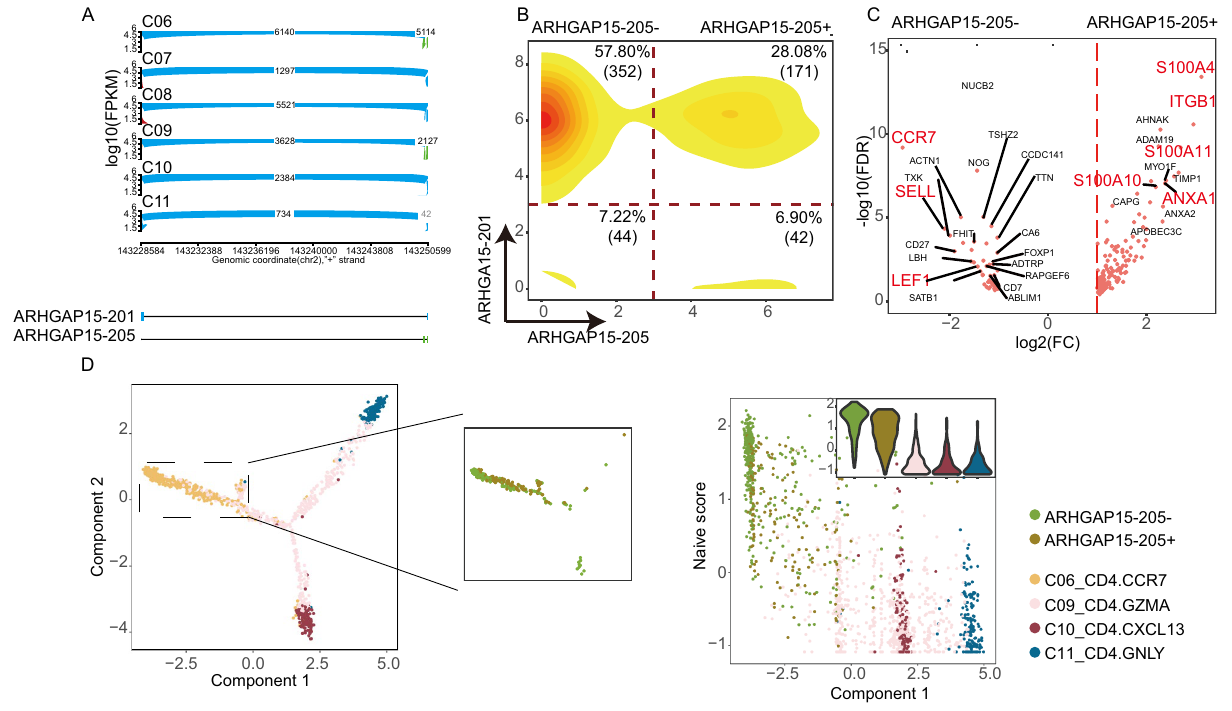
Figure 4. A novel functional subpopulation in activation state identified by ARHGAP15-205. ( A ) Sashimi plots illustrating the read distribution of ARHGAP15 in CD4 + T cells from patient P0508. ARHGAP15-205 is highly expressed in naïve T cells (C06_CD4.CCR7). ( B ) The bimodal distribution of ARHGAP15-205 shows the intrinsic heterogeneity in naïve T cells (C06_CD4.CCR7). Cell density is color-coded, with red denoting high density and yellow denoting low density. ( C ) Volcano plot showing DEGs between the ARHGAP15-205 + and ARHGAP15-205 − populations. Each red dot denotes an individual gene with an adjusted p- value < 0.01 (two-sided moderated t -test with limma) and fold change > |2|. ( D ) Left: CD4 + T helper cells were ordered along pseudotime in a two-dimensional state-space defined by Monocle2. Cell orders are inferred from the expression of DEGs across CD4 + T cell populations. Each point with different colors corresponds to individual cells in different clusters. The middle plot shows the order of the ARHGAP15-205 + and ARHGAP15-205 − populations. Right: The exhaustion score calculated by the mean expression of gene sets related to naïveness status correlated with Monocle components. Violin plots in the top corners show the distribution of naïveness scores in various cell clusters. Different colors represent different clusters. p -values were calculated by Pearson correlation, and p < 2.2 × 10 –16 represents a p- value approaching